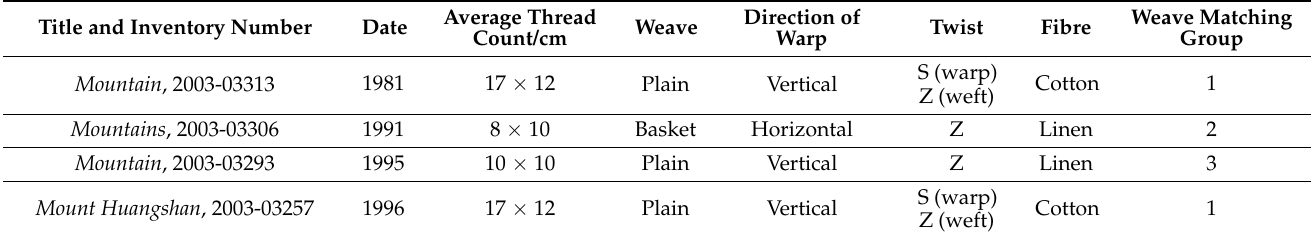
Table 2. Overview of the canvas characteristics of the investigated paintings.